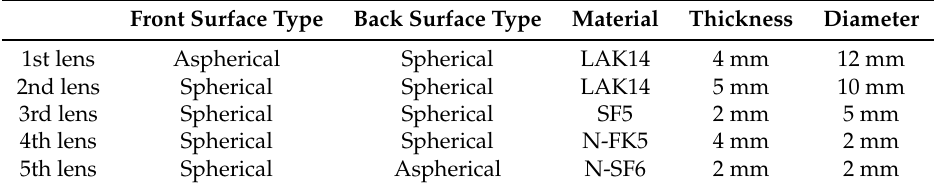
Table 1. Lens data: surface types, materials, thicknesses and diameters. The first and last lens surfaces are aspherical. The first two lenses are made of LAK14 to bend the incoming rays efficiently. The last two lenses form an ahcromatic doublet.